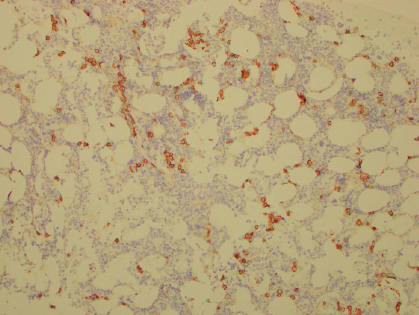
Figure 3: CD138 immunohistochemical stain (Giemsa background) of bone marrow biopsy showing scattered plasma cells in a physiologic distribution with no evidence of